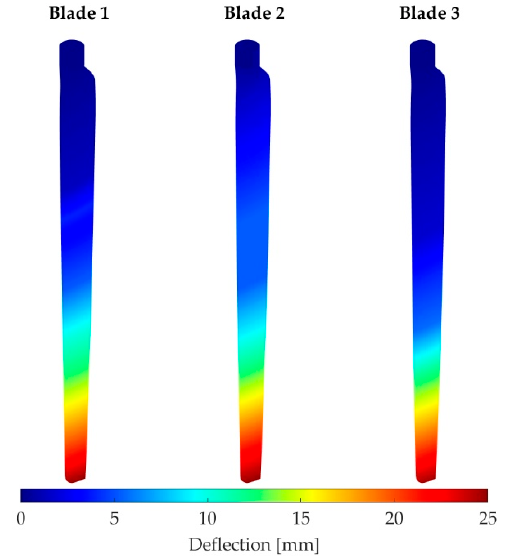
Figure 10. Global blade deflection with steady inflow.